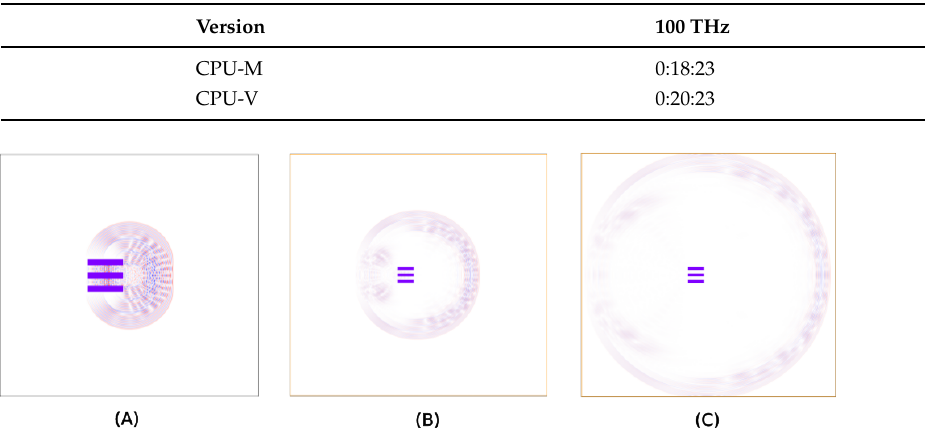
Table 17. Execution times obtained using the CPU in serial form, expressed in mm:ss, for the nanowaveguide propagation.